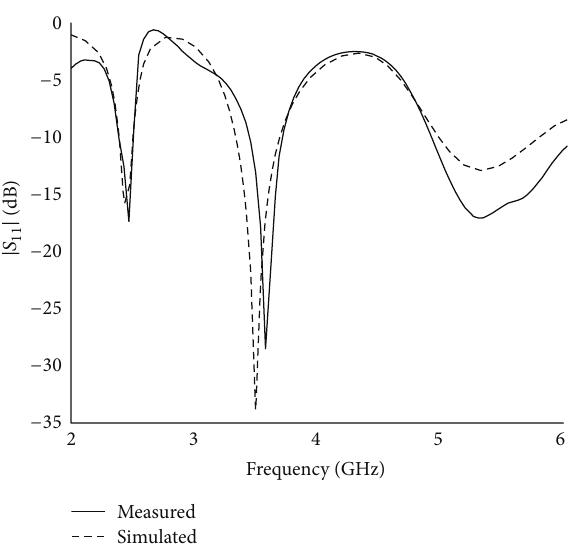
Figure 4: Simulated and measured return loss of the proposed antenna.